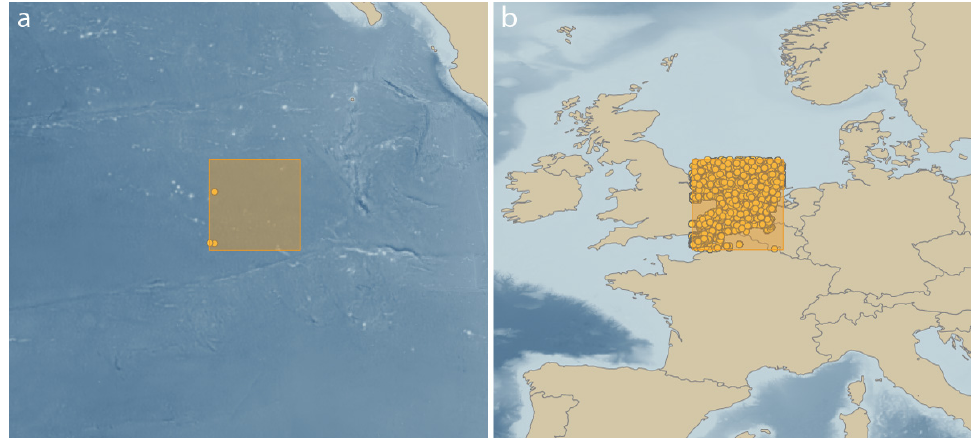
Figure 4. Current online databases list only 4 polychaete records from a 300,000 km 2 search box centred over the UK-1 polymetallic nodule exploration claim area, none of which are benthic species ( a ); In comparison, the same size search box centred on the North Sea between the Netherlands and the UK lists 182,939 records from 61 datasets ( b ); Even expanding the search criteria to the entire 6 million km 2 CCZ produces no published online benthic polychaete records. Data from OBIS